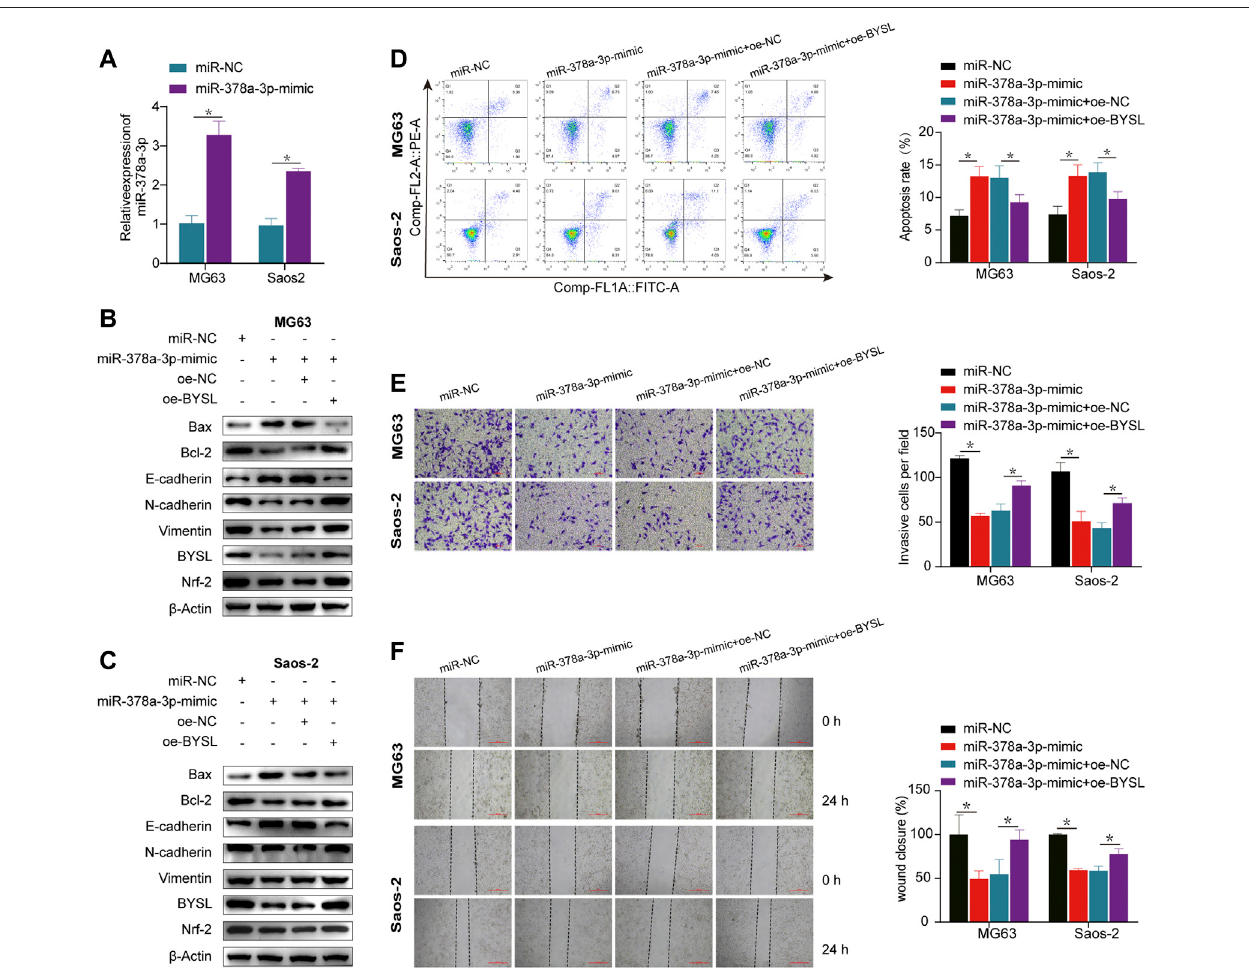
FIGURE 4 | BYSL overexpression rescues the effect of miR-378a-3p overexpression on osteosarcoma cells under hypoxia. (A) MG63 and Saos-2 cells were transfected with control-mimic (miR-NC) or miR-378a-3p-mimic, and then cultured under hypoxic conditions. The RNA level of miR-378a-3p was measured by RT- qPCR. (B,C) MG63 and Saos-2 cells were transfected with control-mimic (miR-NC), miR-378a-3p-mimic, control plasmid (oe-NC), or BYSL overexpression plasmid (oe-BYSL), and then cultured under hypoxic conditions. The protein levels of Bax, Bcl-2, E-cadherin, N-cadherin, vimentin, BYSL and Nrf2 were measured by westernblot. (D) MG63andSaos-2cellsweretransfectedwithcontrol-mimic(miR-NC),miR-378a-3p-mimic,controlplasmid(oe-NC),orBYSLoverexpressionplasmid (oe-BYSL), and then cultured under hypoxic conditions. Cell apoptosis was measured by fl ow cytometry. (E) MG63 and Saos-2 cells were transfected with control- mimic (miR-NC), miR-378a-3p-mimic, control plasmid (oe-NC), or BYSL overexpression plasmid (oe-BYSL), and then cultured under hypoxic conditions. Cell invasion wasmeasured by matrigel invasion assay. Scale bar (cid:1) 100 µm. (F) MG63 and Saos-2 cells were transfected with control-mimic (miR-NC), miR-378a-3p-mimic, control plasmid (oe-NC), or BYSL overexpression plasmid (oe-BYSL), and then cultured under hypoxic conditions. Cell migration was measured by scratch wound healing assay. Scale bar (cid:1) 500 µm. The data are presented as the mean ± SD. * p <